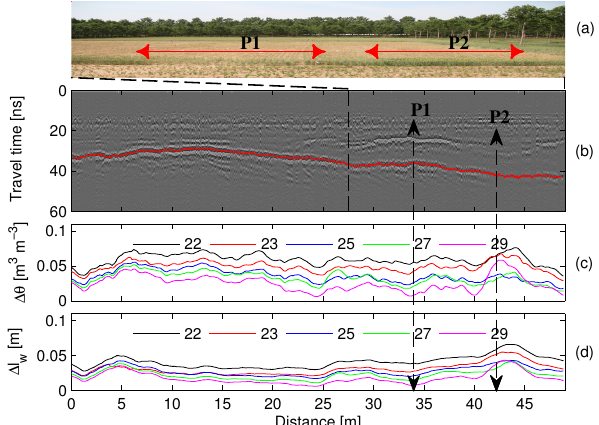
Fig. 12. The influence of soil layering on field-scale soil water dy- namics and surface crops (e.g. the line p25 in Fig. 3). (a) Previous wheat feature in the line p25 demonstrated by the wheat difference (lines: P1 and P2) nearby the line without cutting the wheat; (b) fea- tures of soil layering (red line: dune structure) in the radargram; (c) and (d) time lapse of the estimated soil water content change 1θ and the total water volume change 1l w relative to the measure- ments on 19